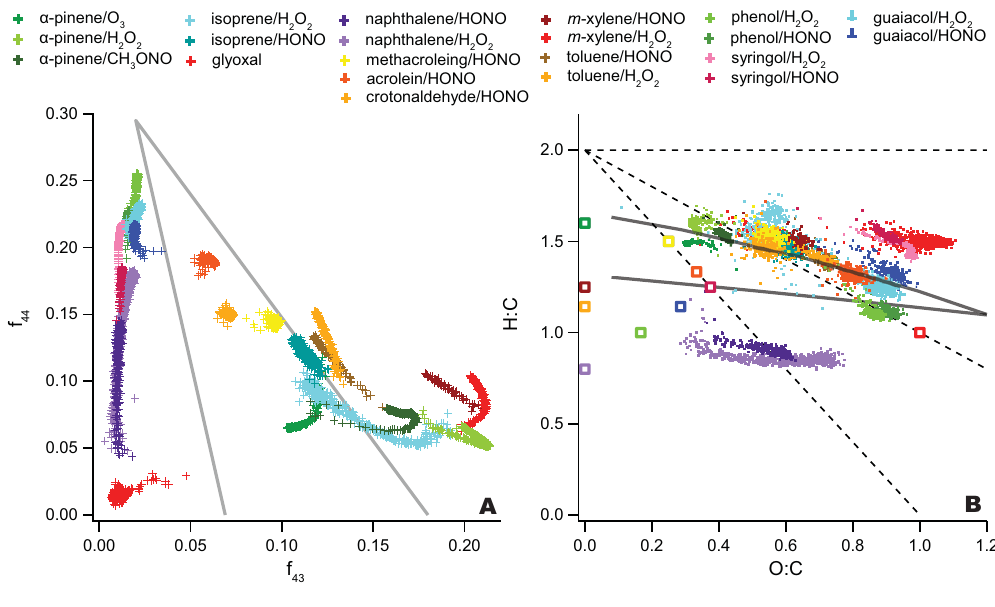
Fig. 9. (A) Triangle plot for all SOA systems (B) Van Krevelen diagram for all SOA systems. SOA precursors are represented by corre- sponding colored boxes. The “VK-triangle” parameterization developed by Ng et al. (2011) is represented by solid gray curves.